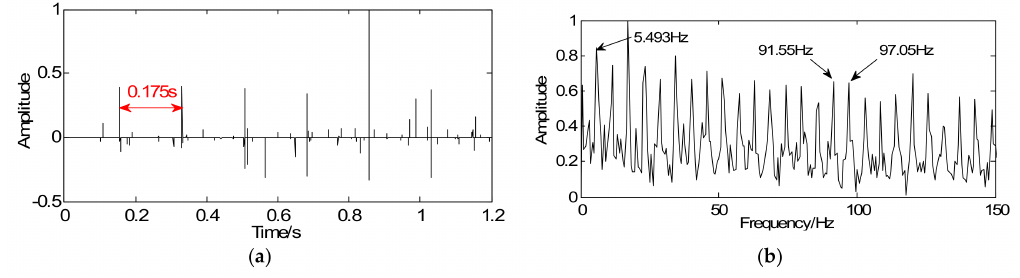
Figure 12. Detection results of tooth-broken fault using the proposed method: ( a ) waveform of sparse signal and ( b ) envelope spectrum of the sparse